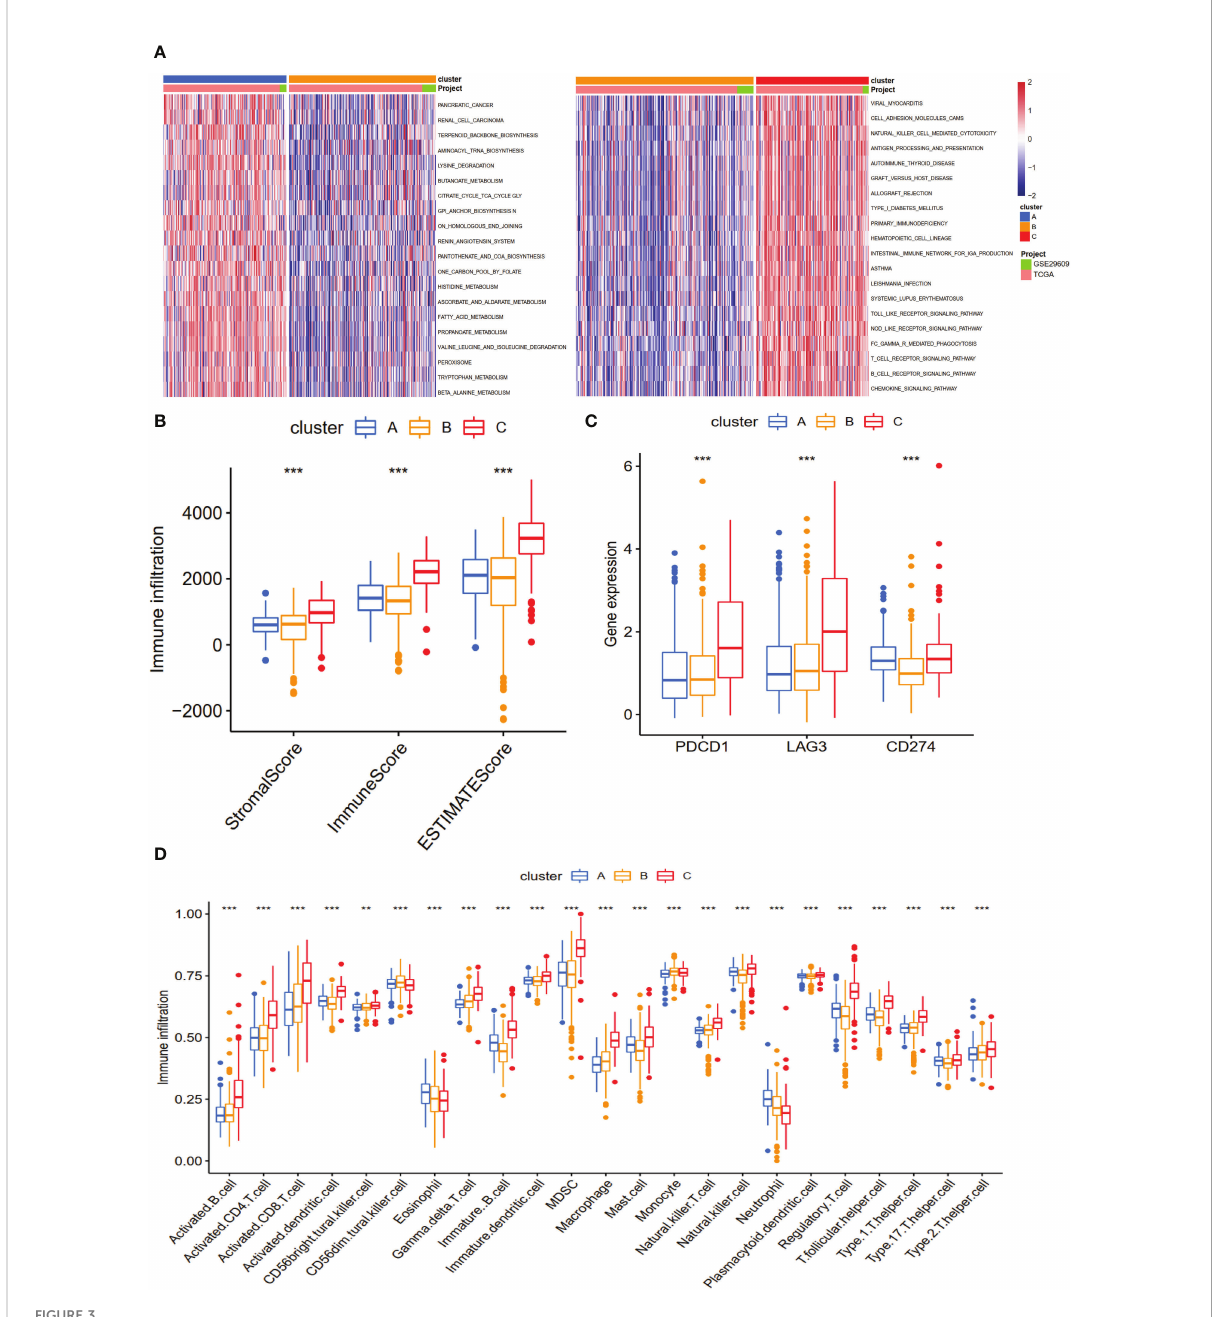
FIGURE 3 The biological characteristics and landscape of immune status among different subtypes. (A) KEGG enrichment analysis of three NET subtypes. (B) The ESTIMATE proportion of stromal score, immune score, and ESTIMATE score among the three clusters. (C) The gene expression pro fi les of three common immune checkpoint genes, PDCD1, LAG3, and CD274. (D) The in fi ltration levels of 23 immune cell types among three subtypes. **p < 0.01, ***p <